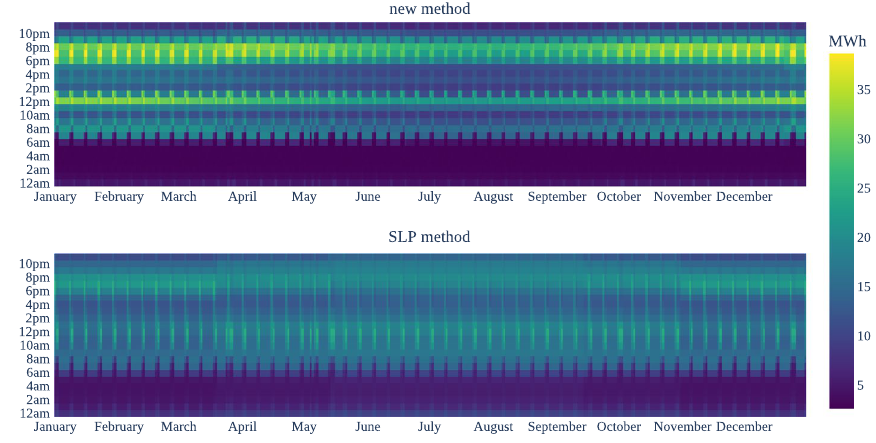
Fig. 5 Electricity demand at MVGD level